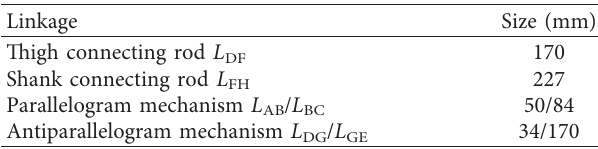
Figure 5: Schematic diagram of leg mechanism. Table 2: Parameters of each